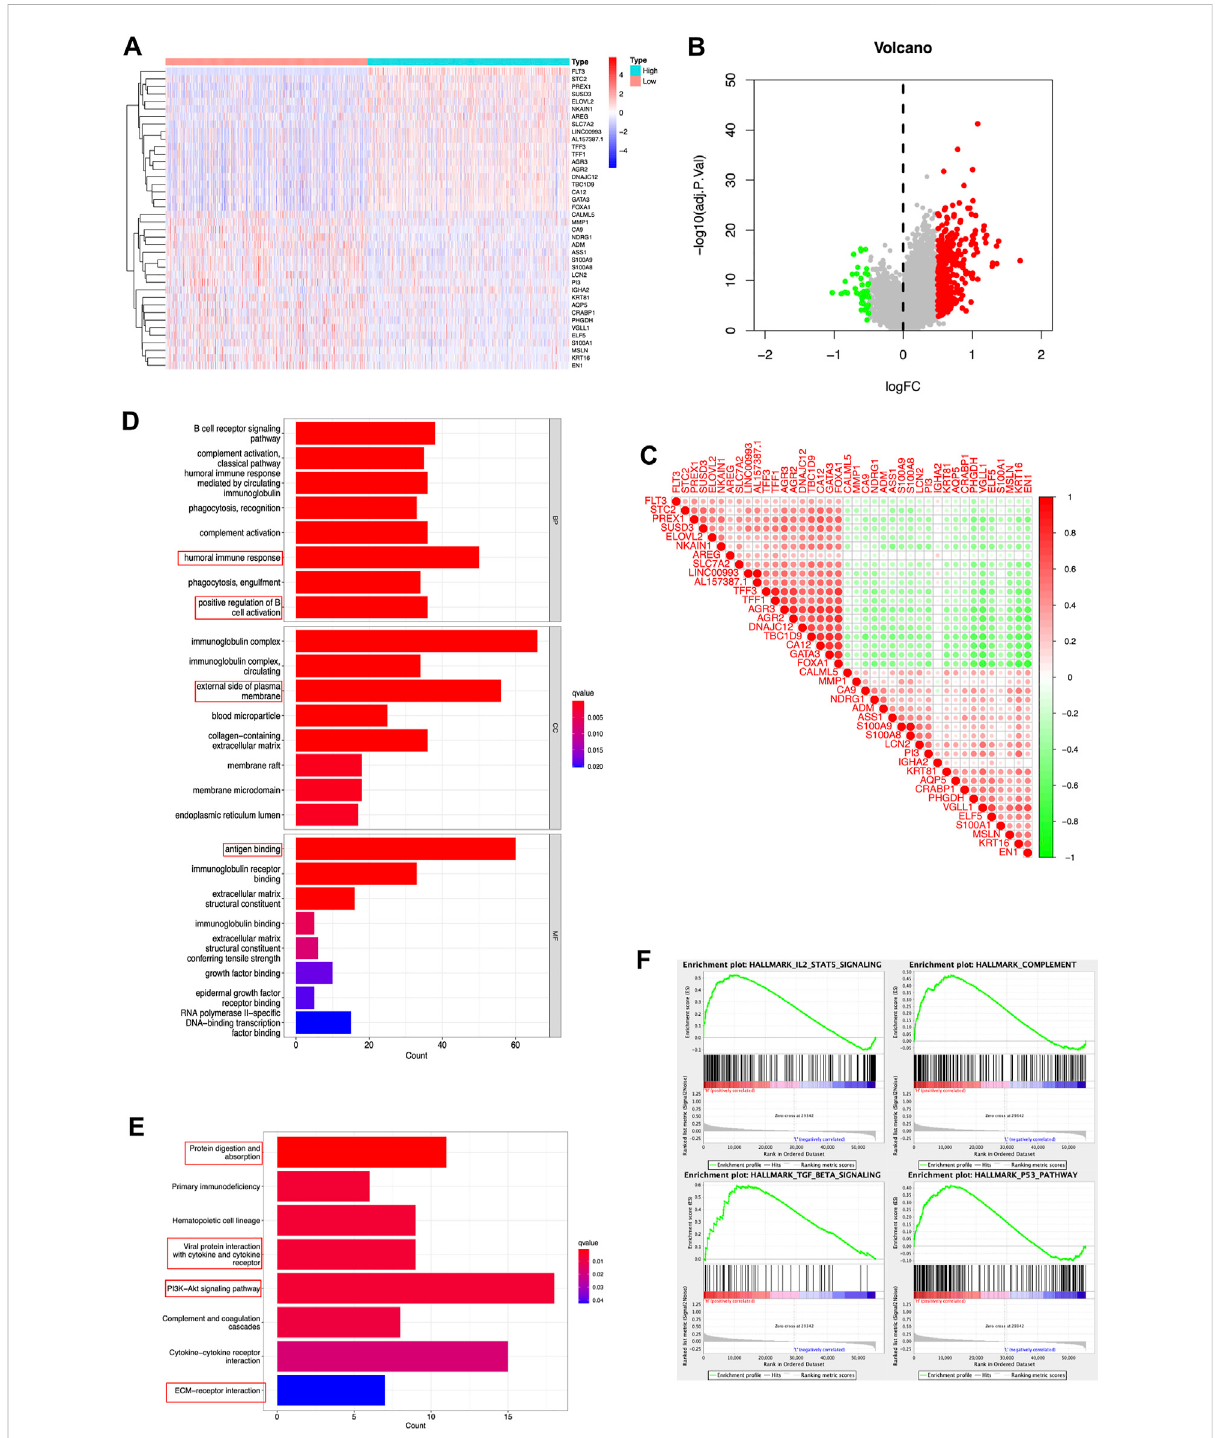
FIGURE 3 DEGs and enrichment analyses of FLT3 in BC. (A) Heatmap and (B) volcano plot show the DEGs in high and low FLT3 expression patients. (C) Correlation of FLT3 and the top 40 co-expressed genes. (D,E) GO enrichment and KEGG pathway analysis of FLT3 in BC. The red box highlights the pathways correlated with BC and immune in fi ltrates. (F) The GSEA results showed that the terms “ complement ” , “ IL2-STAT5 signaling ” , “ TGF-BETA signaling ” and “ p53 pathway ” were differentially enriched in BC samples with high